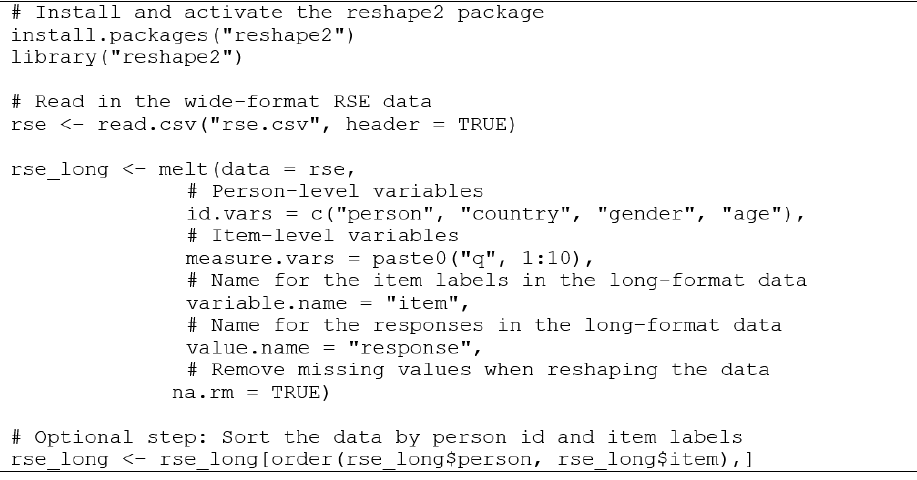
Figure 1. Transform the wide-format RSE data to the long-format data. A snapshot of the difference between the wide-format and long-format versions of the RSE data can be seen in Table 1. Unlike in the wide-format data, items in the long-format data are nested within persons and thus the same person has multiple rows (i.e., the same person has 10 rows representing 10 items in the RSE